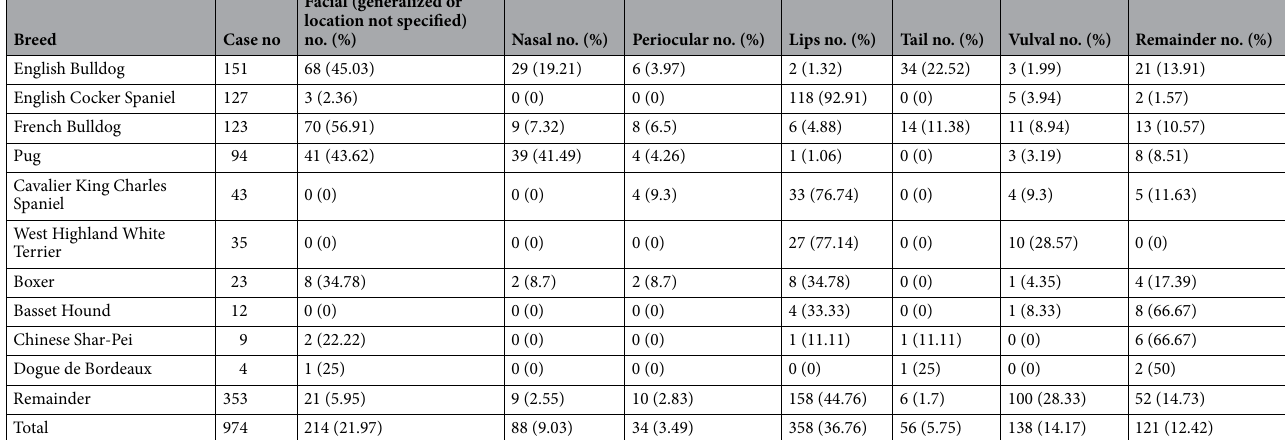
Table 2. Commonly recorded locations for skin fold dermatitis in the 10 breeds with the highest prevalence in dogs under primary veterinary care during 2016 in the VetCompass Programme in the UK.